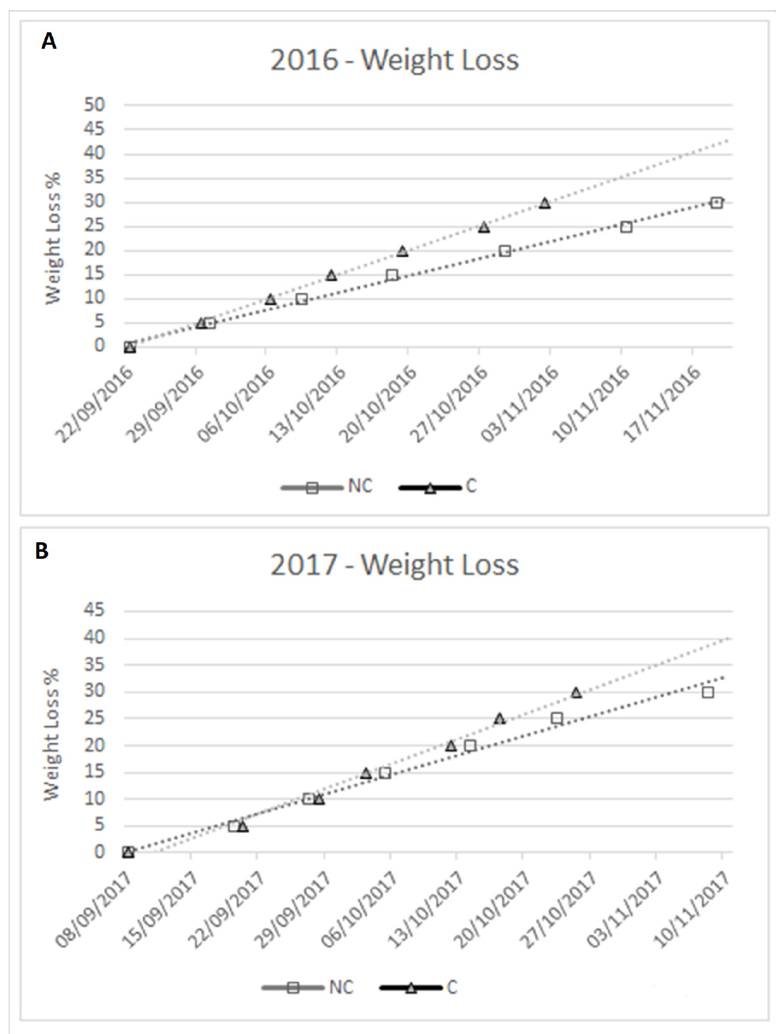
Figure 3. Kinetics of withering: WL in 2016 ( A ) and 2017 ( B ).